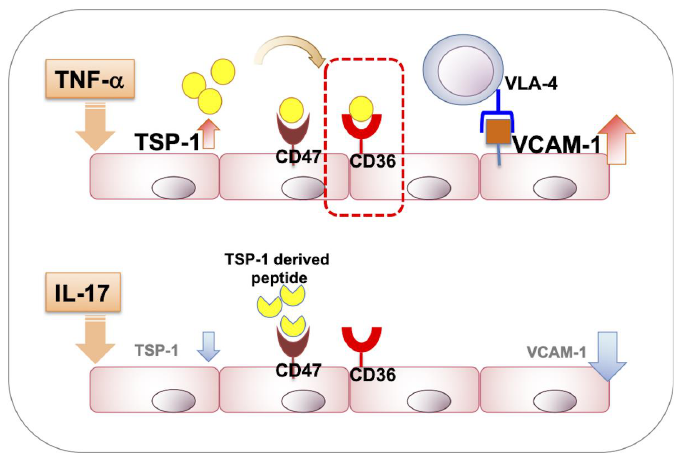
Figure 7. Schematic representation of the involvement of TSP-1 and its receptors, CD47 and CD36, in regulating VCAM-1 expression in vascular endothelial cells exposed to TNF- α vs. IL-17. Predominant signaling via CD36 drives increased VCAM-1 expression mediated by endogenous TSP-1, which is increased in response to TNF- α . However, IL-17 exposure of cells reduces their endogenous TSP-1 expression, allowing the dominance of inhibitory CD47 signaling that downregulates VCAM- 1